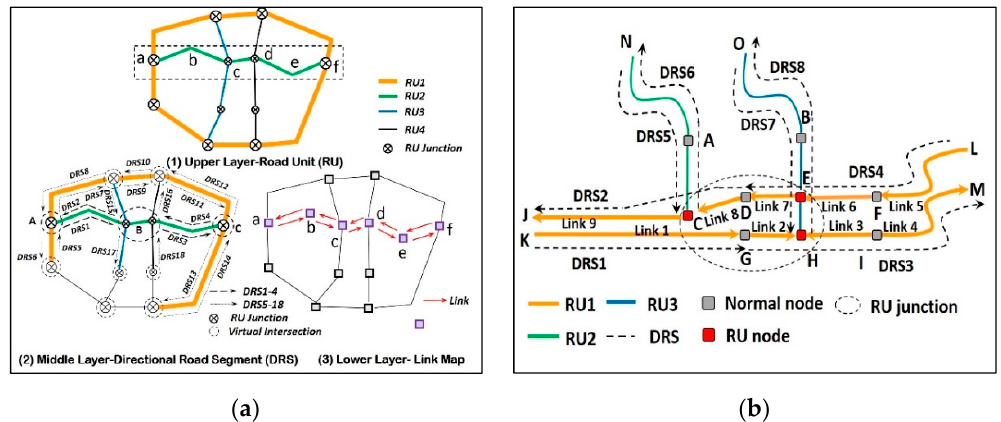
Figure 2. Multi-layer road index (MRI) system. ( a ) Three layers in an MRI system. ( b ) An example of the MRI system.